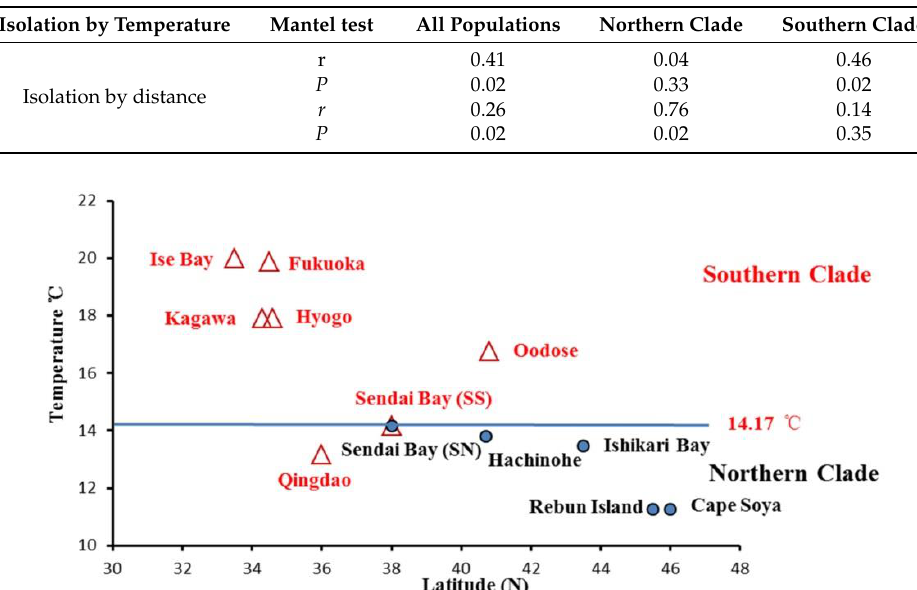
Table 5. Results of Mantel tests ( F ST vs. temperature, Log F ST vs. geographic distance Log KM) at the different spatial scales.